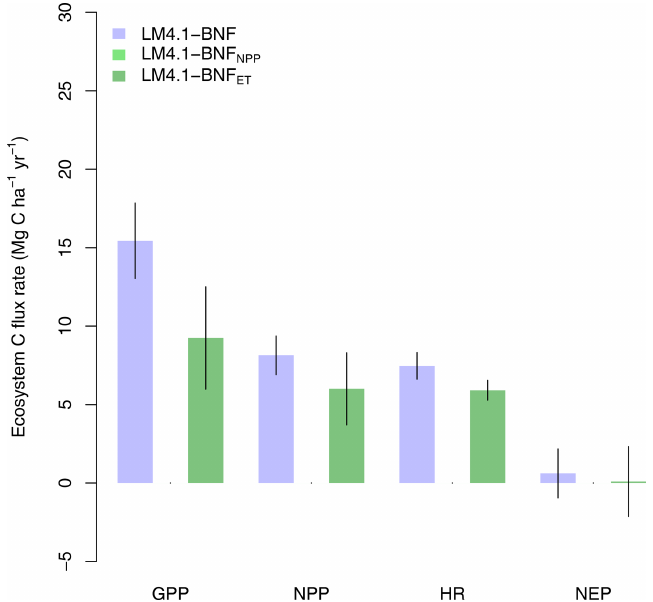
Figure D6. Simulated gross primary production (GPP), net primary production (NPP), heterotrophic respiration (HR), and net ecosystem production (NEP) from LM4.1-BNF, LM4.1-BNFNPP, and LM4.1-BNFET. Simulated data are averaged over the last 100 of the 300 years of simulation to reflect the data which are from mature forests. Error bars indicate 2 standard